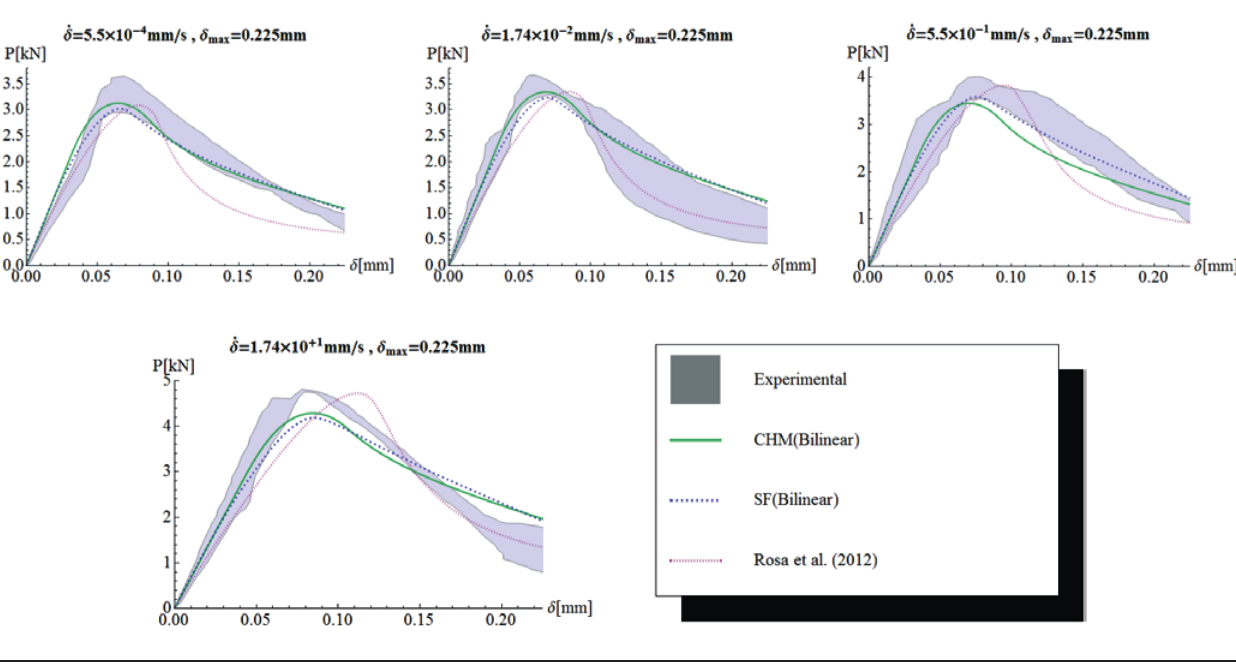
Figure 17 – Fit curve for the range of 0 to 0.225 mm using bilinear curve set in section 5.3P-